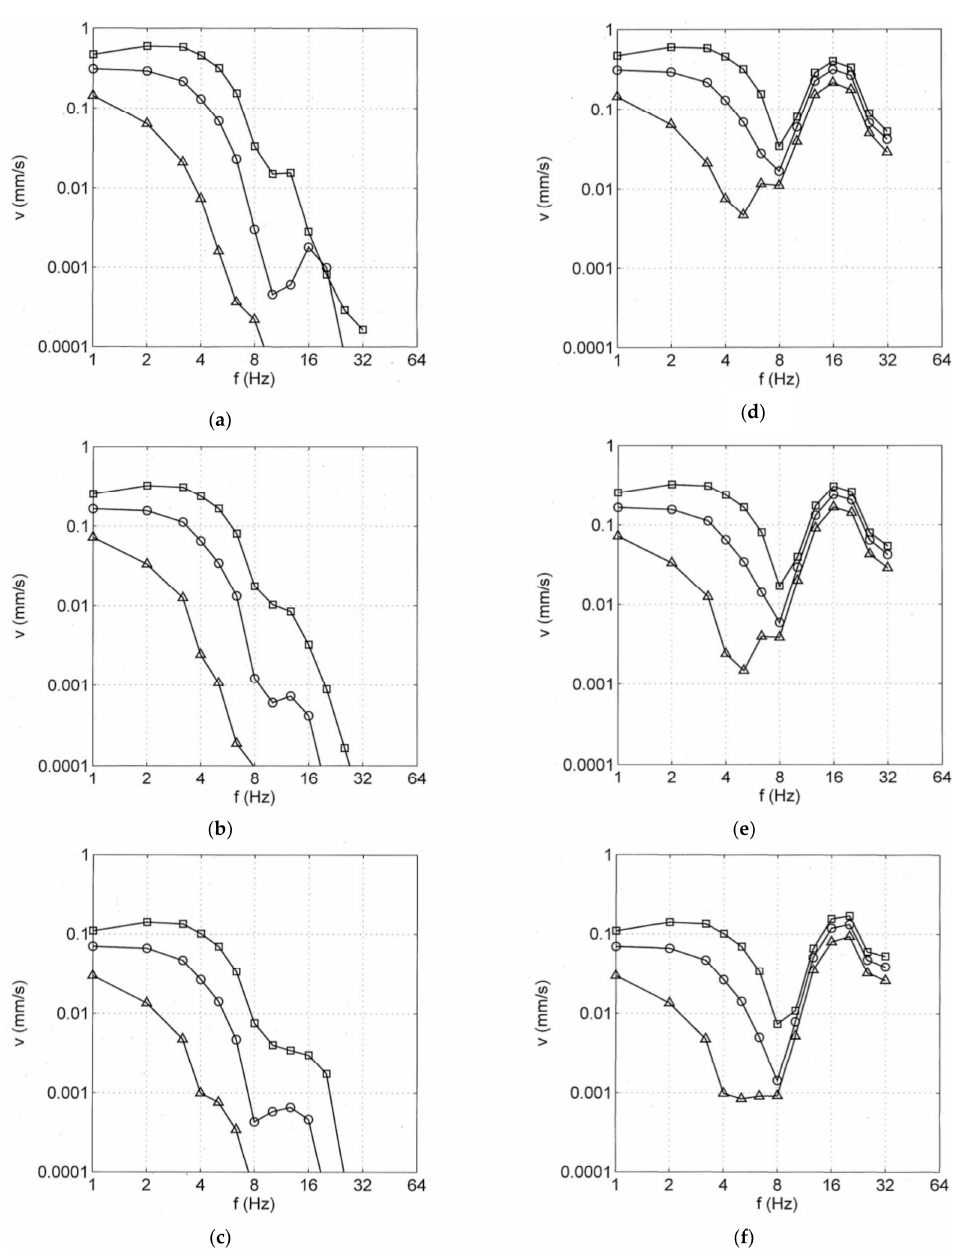
Figure 6. Train passage with v T = 160 km/h over a regular ( a , c , e ) and an irregular ballast track ( b , d , f ), q = 50%), different soils with v S = ( a , b ) 150, ( c , d ) 200, ( e , f ) 300 m/s, one-third of the octave band spectrum at distances x = □ 3, ○ 5, ∆ 10 m.